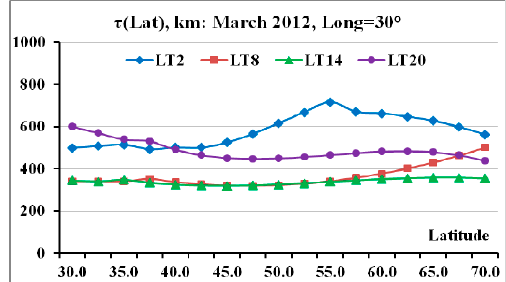
Figure 2. Latitudinal dependence of the median of the equivalent slab thickness, calculated according to the data of four ionosondes lying near the longitude of 30° E. Daytime values are characterized by a smooth curve and constancy in a wide range of latitudes. The peak of nighttime values of τ (Lat) falls on the region of the main ionization trough.